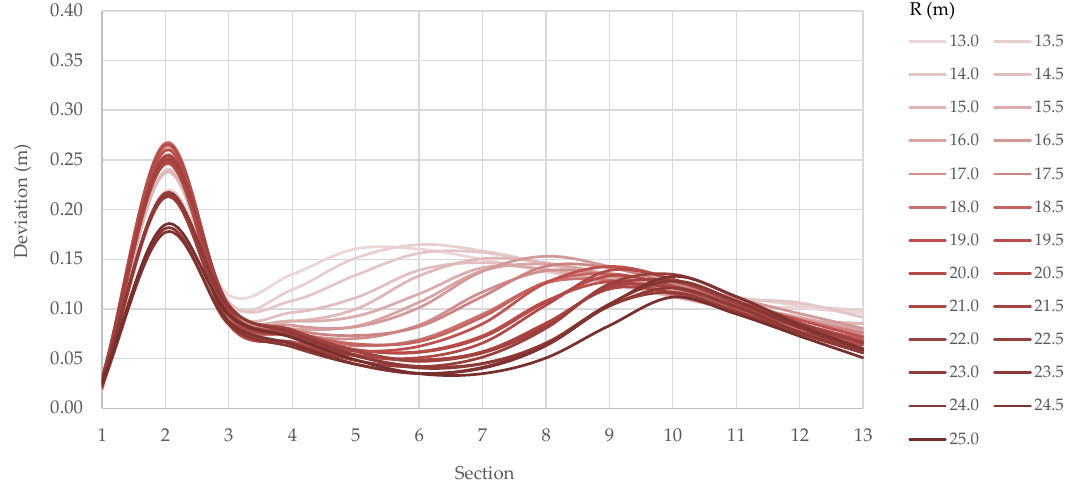
Figure 9. Chassis left-hand-side trajectory deviations.